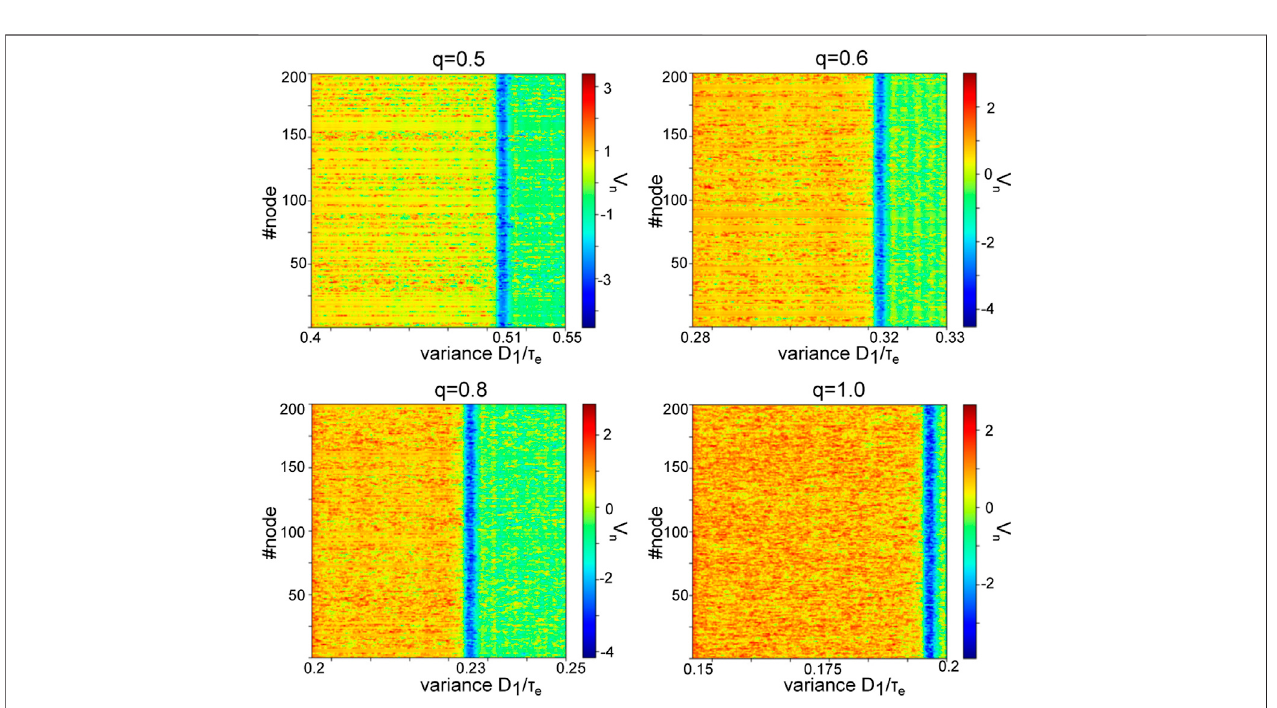
FIGURE 4 | Enhanced zero-mean Gaussian noise induces phase transitions in spatiotemporal dynamics. The panels show the network activity V ( t ) according to Eq. 1 with temporally increasing noise variances D 1 / τ e for different stimulus ratios q .